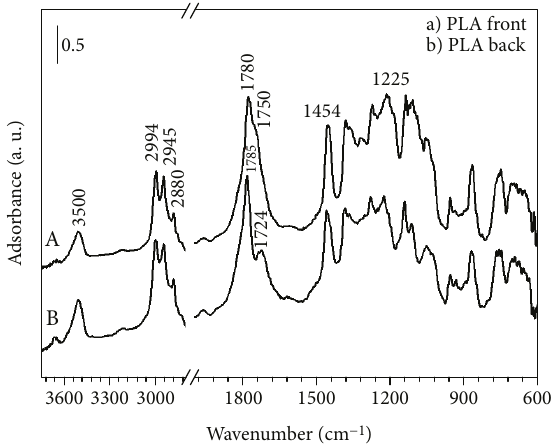
Figure 3: DR-FTIR spectra in the range 3700 – 700cm − 1 of (a) “ front ” and (b) back of P LA DL